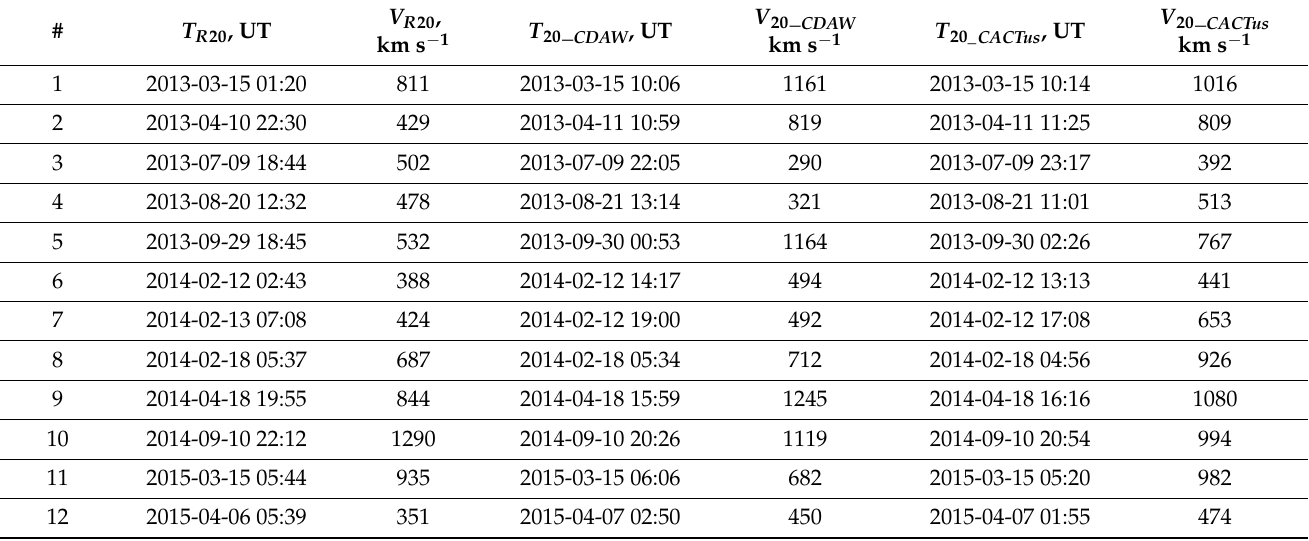
Table 6. Parameters of the CME sources identified from the CACTus and CDAW